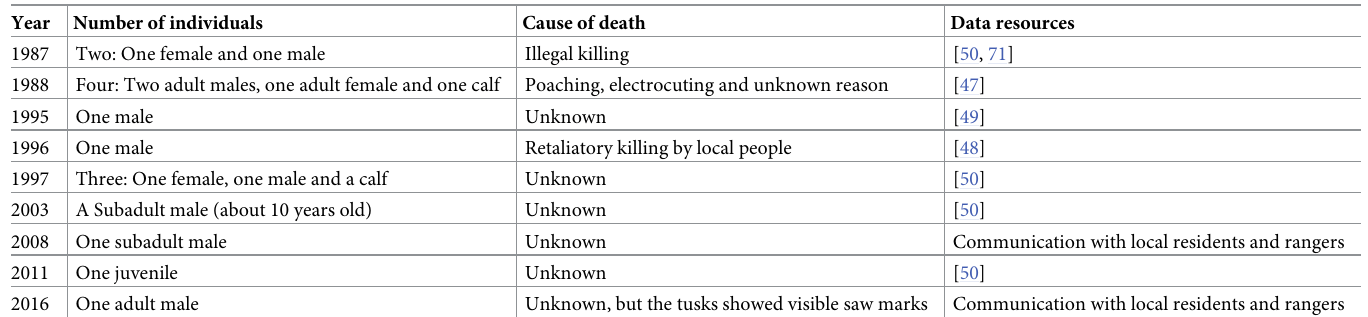
Table 5. Unnatural deaths of Asian elephant since the establishment of